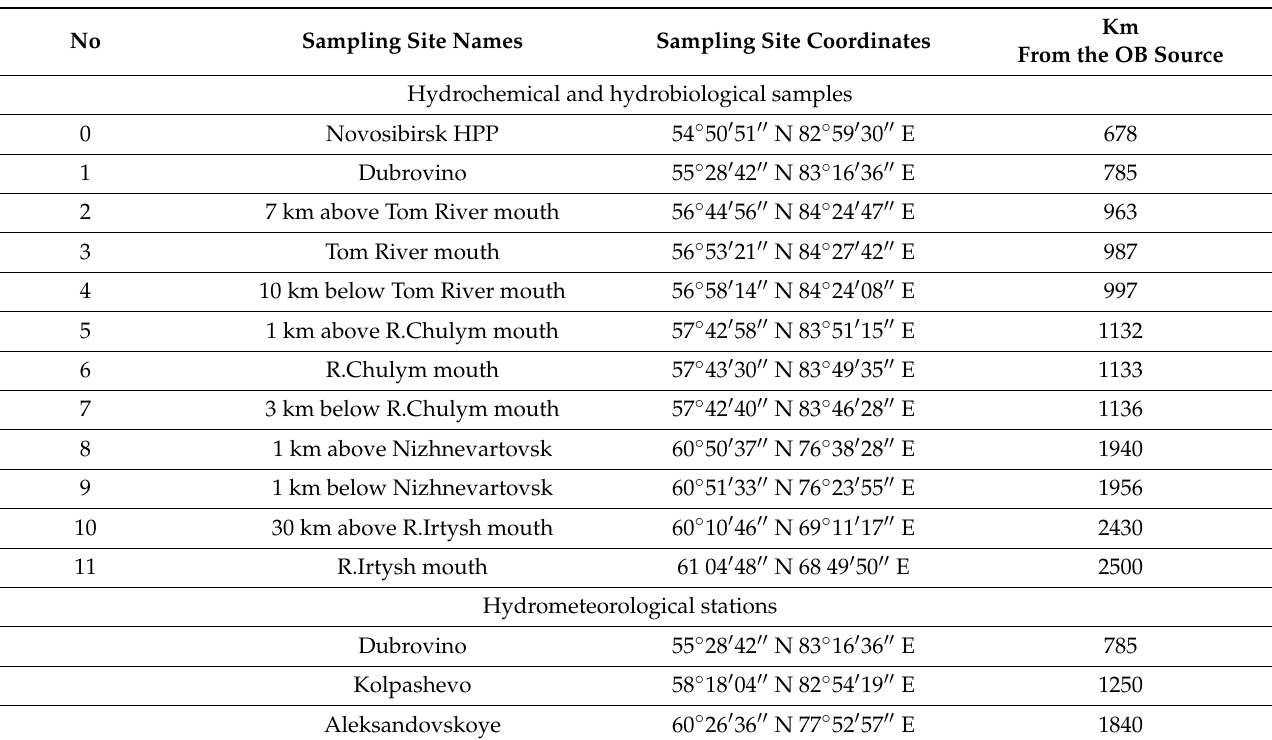
Table 1. Location of sampling sites and hydrometeorological